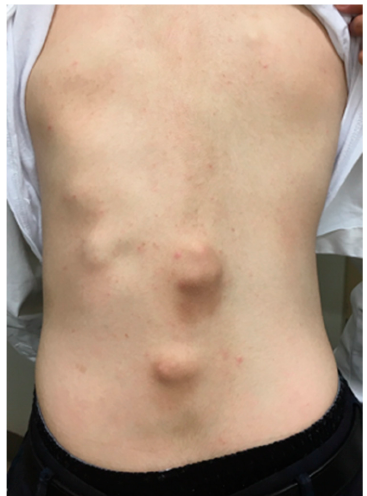
Figure 1. Sixteen-year-old male with fibrodysplasia ossificans progressiva (FOP) demonstrating